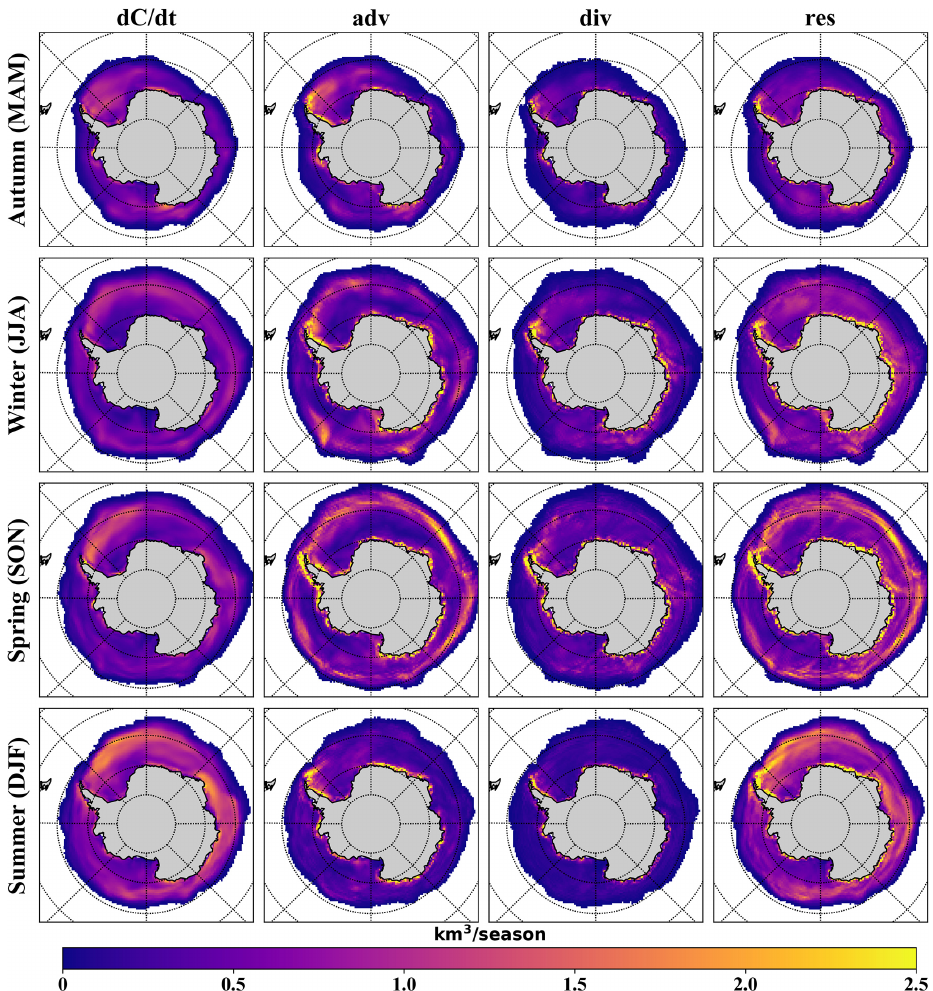
Figure 6. The same as Fig. 4 but for SIV budget. The maximum value of the colour map is limited to 2.5km 3 per season for the best